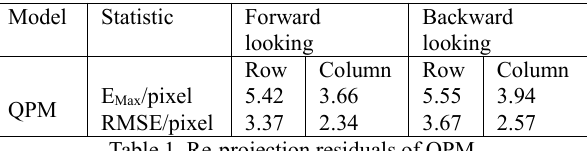
Table 1. Re-projection residuals of QPM